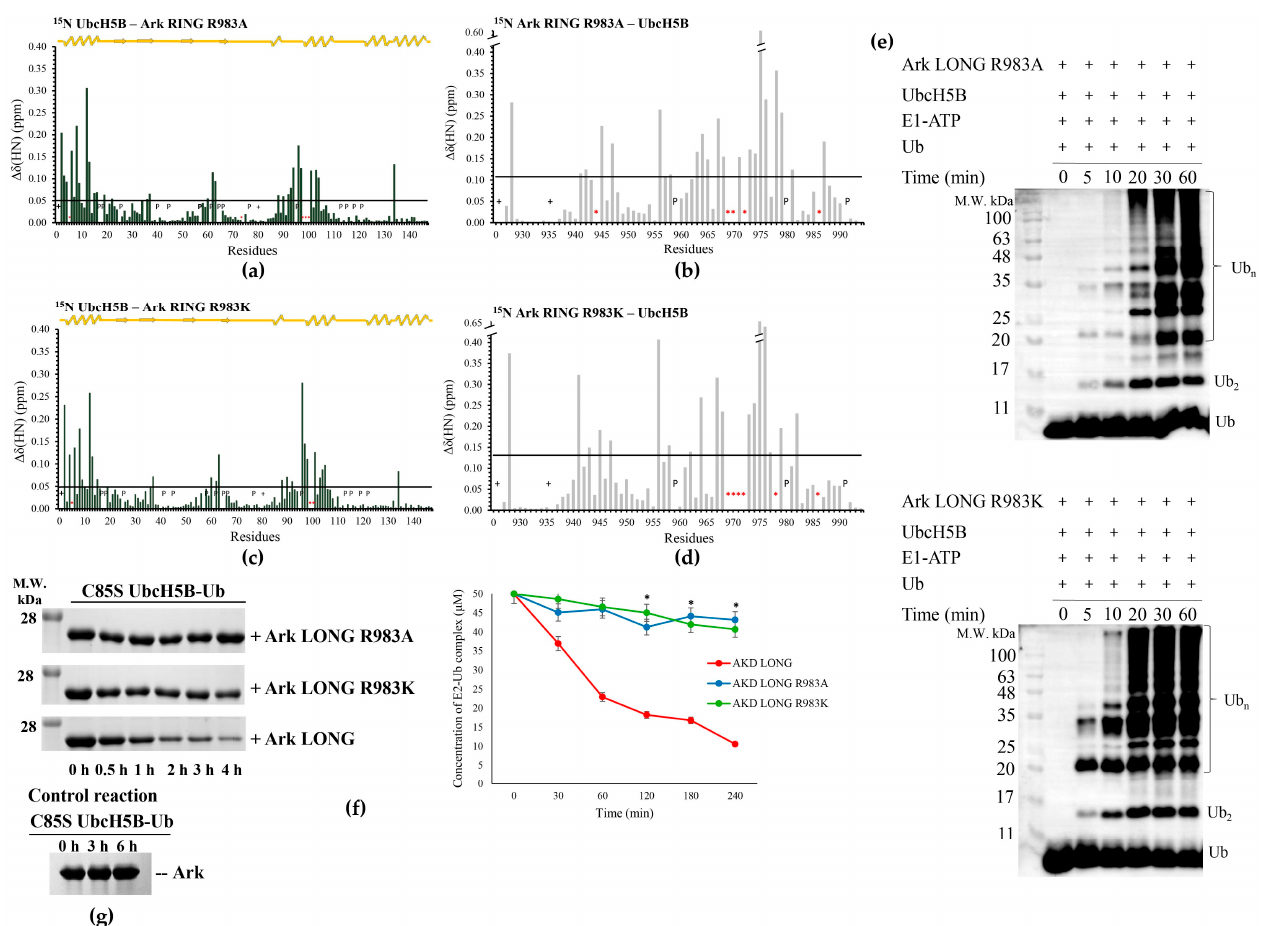
Figure 5. The role of R983 in Arkadia-mediated ubiquitylation. ( a ) Diagram of the total CSPs mea- sured at a 1:2 molar ratio for 15 N UbcH5B/ 14 N Ark RING R983A, *: represents disappeared